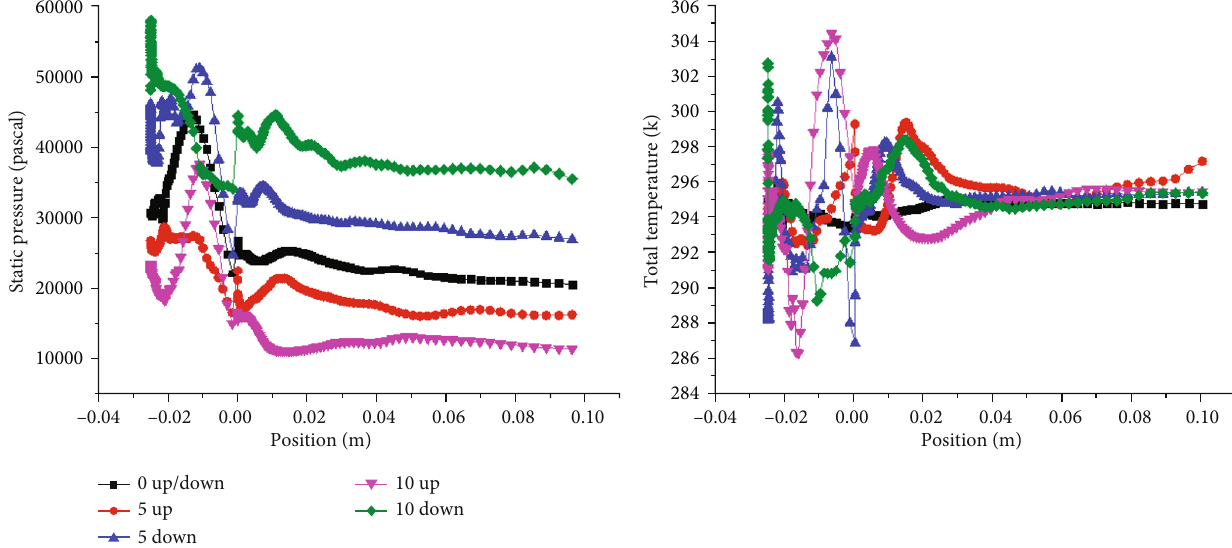
Figure 20: Pr=0.4 wall pressure and temperature distribution at di ff erent angles of attack.